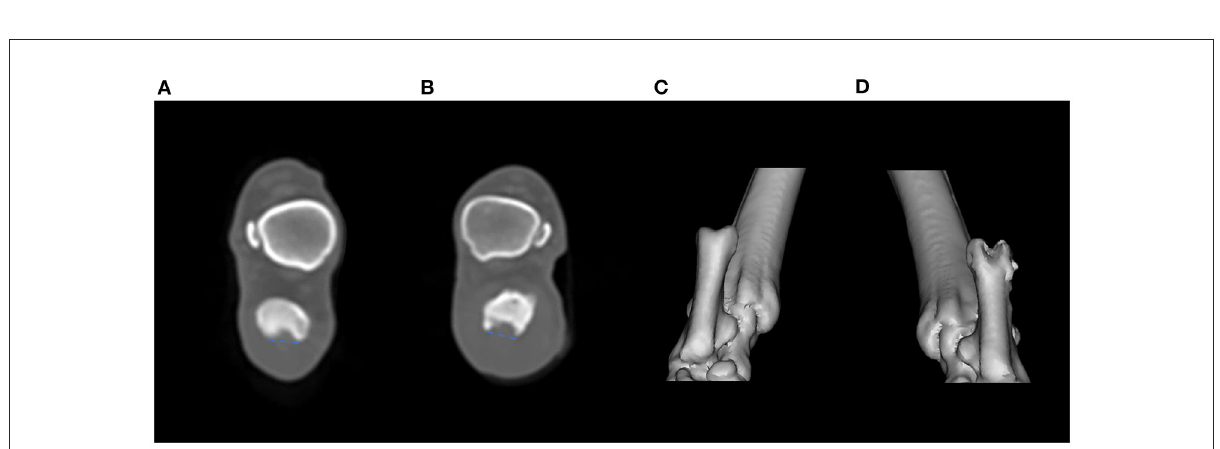
FIGURE4 Postoperative computed tomography of the calcaneal tuber (A,B) . The calcaneal groove depth was measured from the level of medial and lateral calcaneal tuber to the calcaneal groove. The depth of the unaffected left calcaneal tuber (A) was 2mm, and that of the right was 3mm postoperatively (B) . Caudocranial view of the three-dimensional reconstruction of the bilateral calcaneal tuber [ (C) : left, (D) : right]. Note that the right calcaneal tuber groove is deepened compared with the left side.